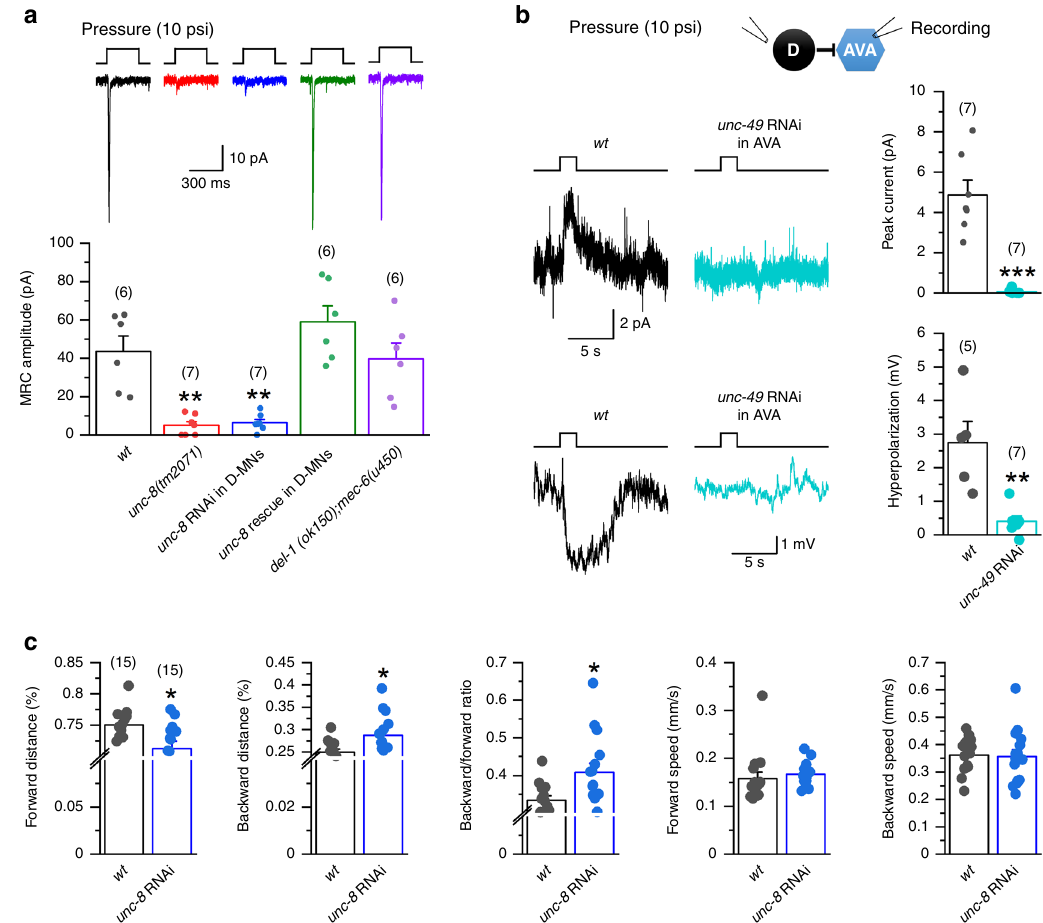
Fig. 3 UNC-8 mediates mechanosensory responses of D-MNs and regulates locomotion through AVA interneurons. a UNC-8 was required for mechanoreceptor current (MRC) caused by ejecting the bath solution at 10 psi in VD5 (held at − 60 mV). Compared with wild type ( wt ), p = 0.001 unc-8 (tm2071) , 0.002 unc-8 RNAi, 0.441 unc-8 rescue, and 0.992 del-1(ok150);mec-6(u450) . b Mechanical stimulation of D-MNs evoked an outward current in AVA and hyperpolarization of AVA in wt but not the AVA-targeted unc-49 RNAi strain. Compared with wt , p = 0.000 for peak current, and 0.002 for hyperpolarization. c GABAergic neuron-targeted unc-8 RNAi did not alter locomotion speed but signi fi cantly increased the ratio of backward/forward movement. p = 0.011 forward distance, 0.011 backward distance, 0.012 backward/forward ratio, 0.541 forward speed, and 0.876 backward speed. The asterisks indicate statistically signi fi cant differences compared with wt (* p < 0.05, ** p < 0.01, *** p < 0.001) based on either one-way ANOVA with Tukey ’ s post hoc test ( a ) or unpaired two-sided t -test ( b, c ). The numbers inside brackets indicate sample size ( n ). n = numbers of independently recorded cells in a and b , but numbers of individual worms in c . Data are presented as mean values ± SEM. Source data are provided as a Source data fi